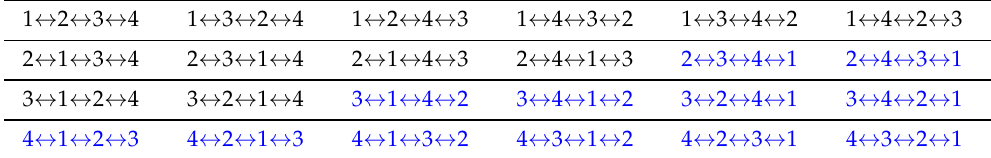
Table 3. Possible chamber interconnection schemes of VDN with linear topology in dual cylinder crane application. Blue colored combinations represent redundant interconnection